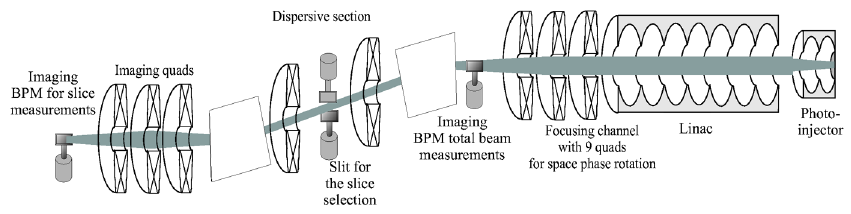
FIG. 5. (Color) Schematic layout of the ATF accelerator system components used in the tomographic